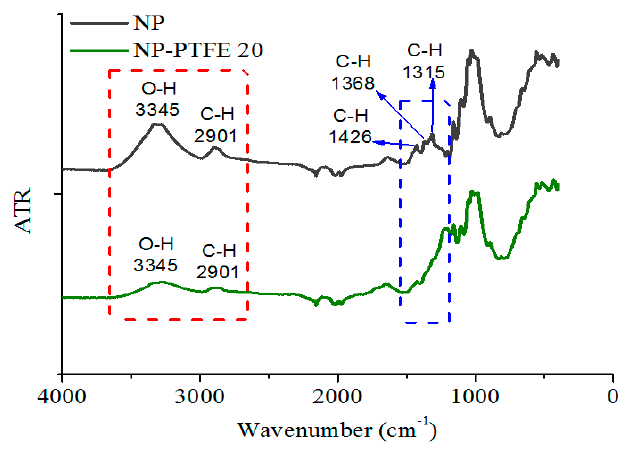
Figure 12. FT-IR of the new pressboard, new pressboard deposited PTFE for 20 min.